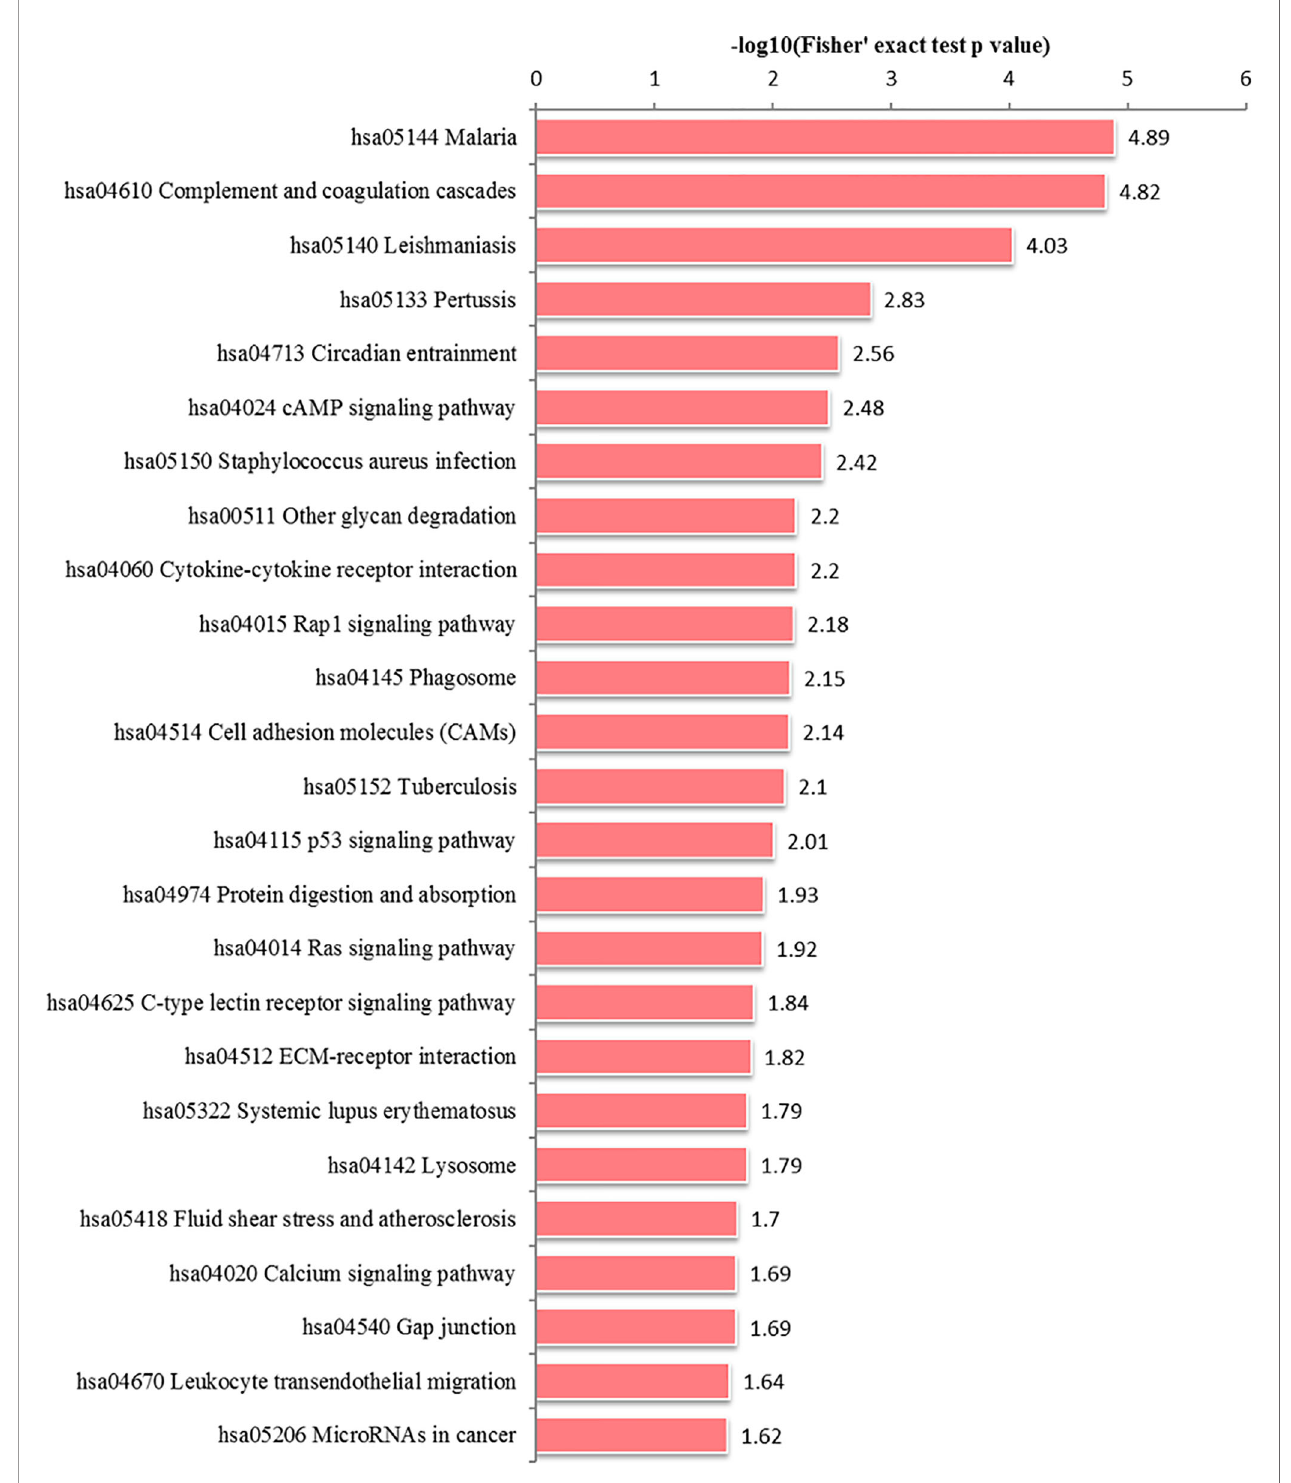
FIGURE 6 | Alteration of signaling pathways in host cells during T. gondii infection. X-axis represents signi fi cantly enriched KEGG pathways. Y-axis represents logarithmic corrected p values [ –